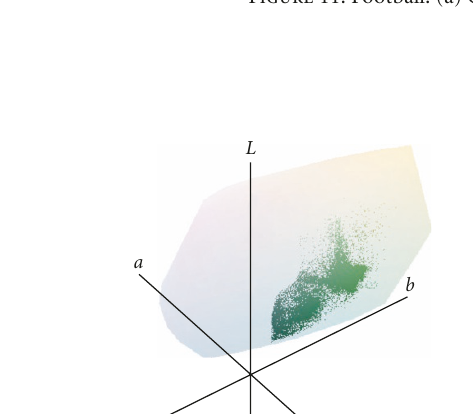
Figure 11: Football. (a) Original image; (b) green region p